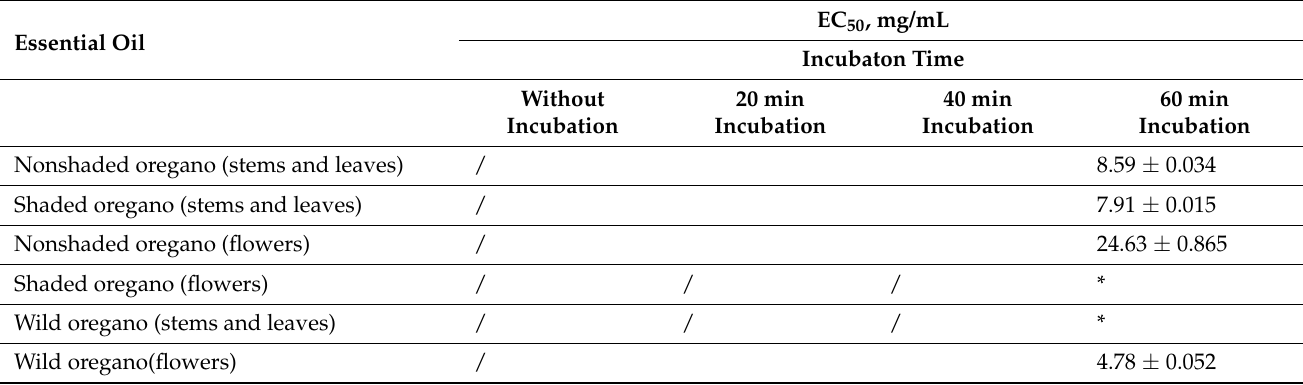
Table 6. EC 50 values of essential oil from the different origin and plants parts of oregano.